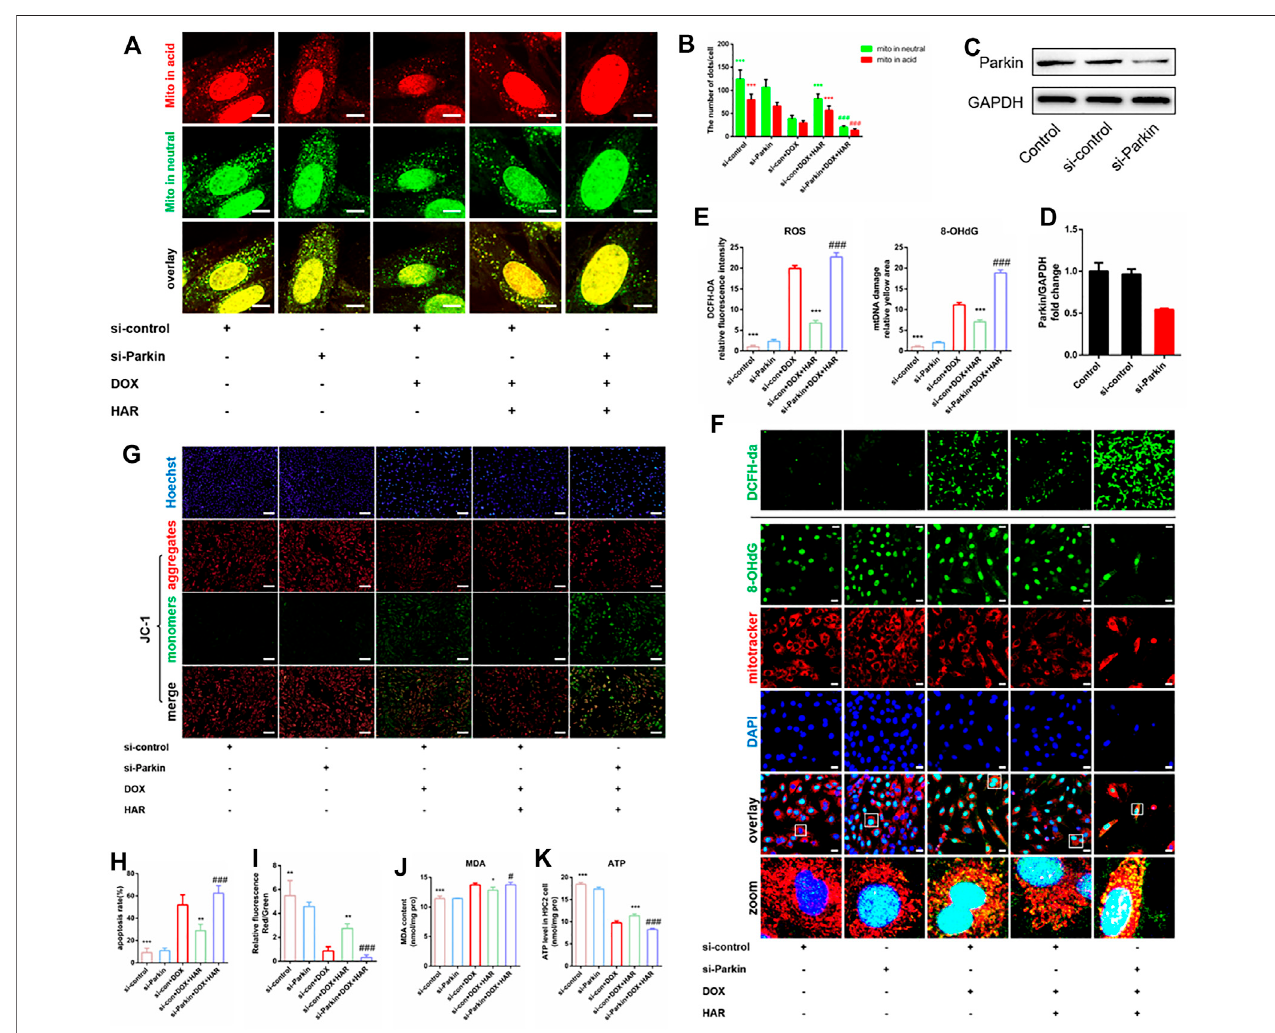
FIGURE 6 | HAR alleviated DOX-induced apoptosis and mitochondrial oxidative stress damage by promoting Parkin-mediated mitophagy in vitro . (A,B) Representative confocal images and quantitative analysis of H9C2 cells infected with mt-Keima adenovirus before transfection with Parkin siRNA ( n = 6). (C,D) Representative immunoblots and quantitative analysis of the protein level of Parkin in H9C2 cells treated with Parkin siRNA. (E,F) Representative confocal images and quantitativeanalysisofH9C2cellsstainedwithDCFH-DAandcostainingof8-OhdGandMitoTrackerafterinfectionwithParkinsiRNA.Scalebars:100and25 μ M. (G – I) Representative images and quantitative analysis of H9C2 cells stained with JC-1 and Hoechst 33,342 after infection with Parkin siRNA ( n = 6). Scale bar: 100 μ m. (J,K) The intracellular contents of MDA and ATP in H9C2 cells ( n = 6). * p < 0.05, ** p < 0.01, *** p < 0.001 vs (si-con + DOX) group. # p < 0.05, ### p < 0.001 vs. (si-con + DOX + HAR) group. The data are shown as the mean ±